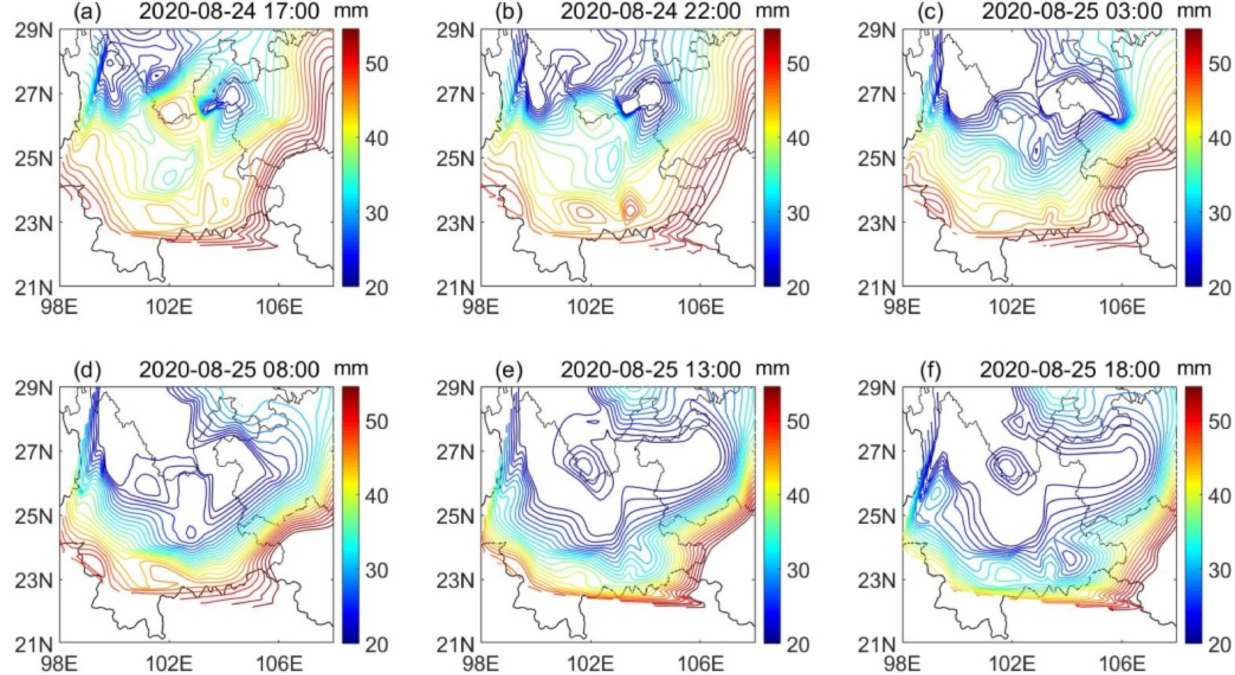
Figure 11. Distribution of PWV in Yunnan–Guizhou Plateau from 17:00 on 24 August (UTC) to 18:00 on 25 August 2020 (the contour color scale represents the PWV, unit: mm. ( a – f ) represent the results of 5 h interval).